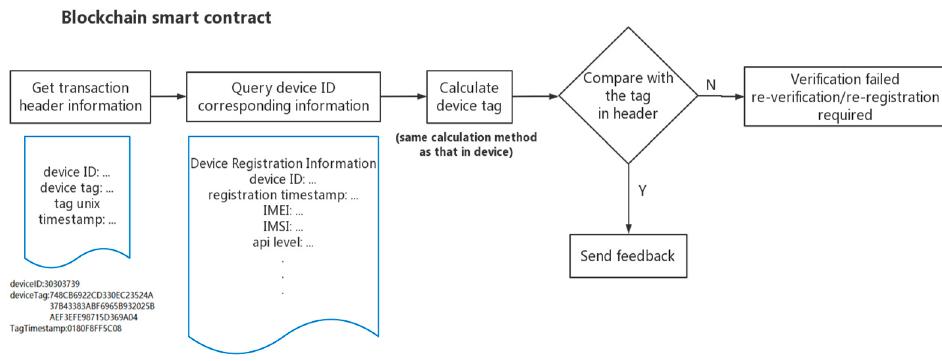
Figure 9. Check verification workflow.